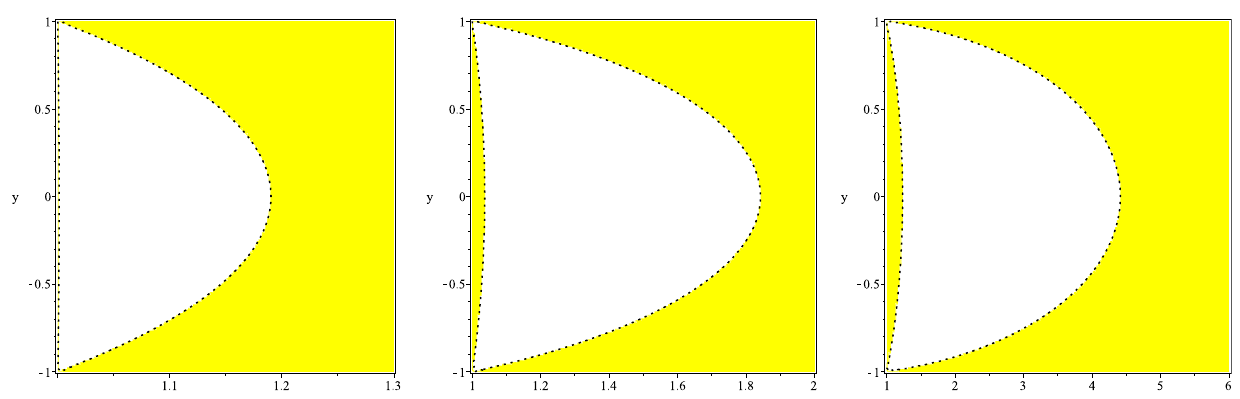
Fig. 1 The yellow regions represents those portions of the ( x , y ) -plane where the inequality A > 0 with A as in (3.87) is satisfied. From left to right we plotted the cases q = 0 . 1, q = 0 . 5 and q = 0 .